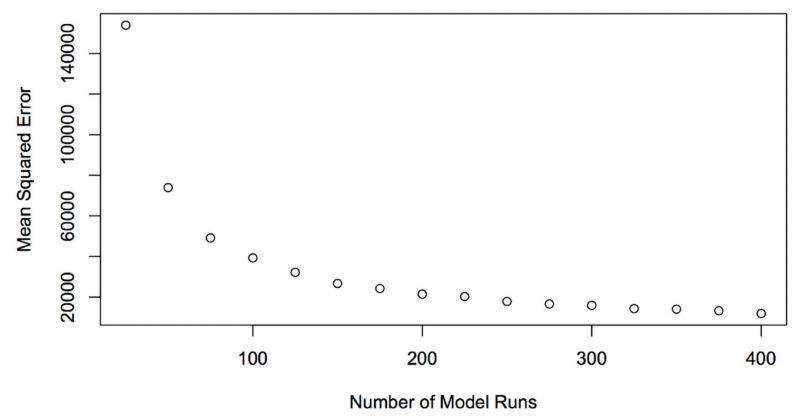
Figure 6. Reduction in out-of-sample mean squared error in a cross-validation experiment as the number of sample model runs is